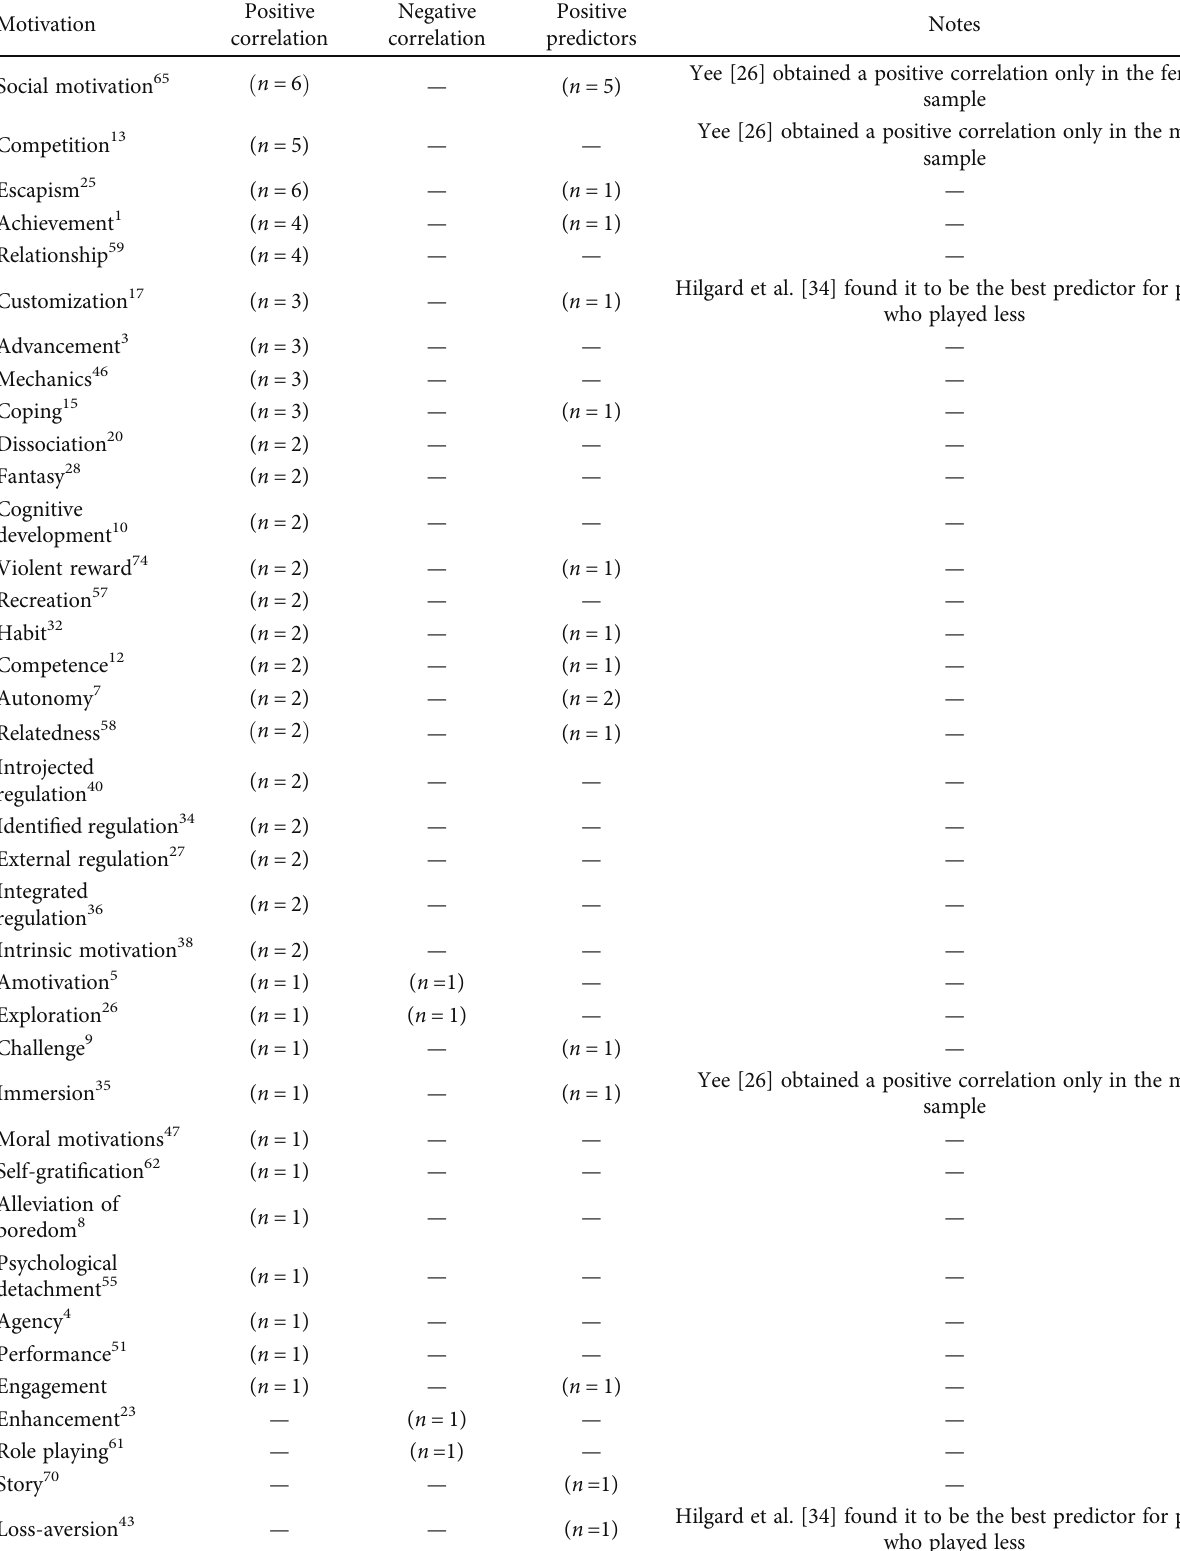
Table 6: The table reports how many studies found positive and negative correlations for each motivation and also how many found that motivation to be a positive predictor of hours played per